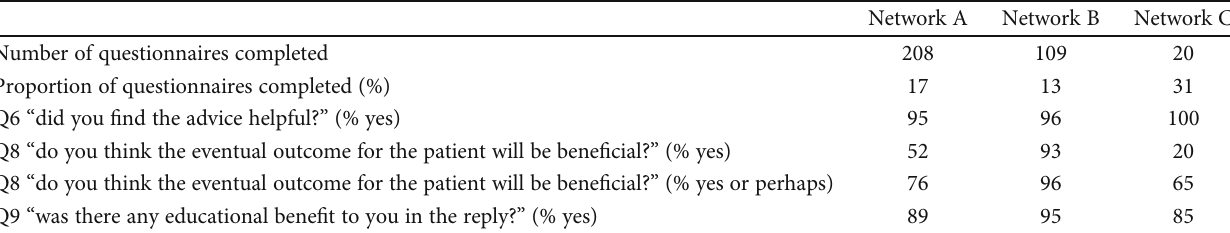
Table 8: User feedback: responses to three of the 12 questions.